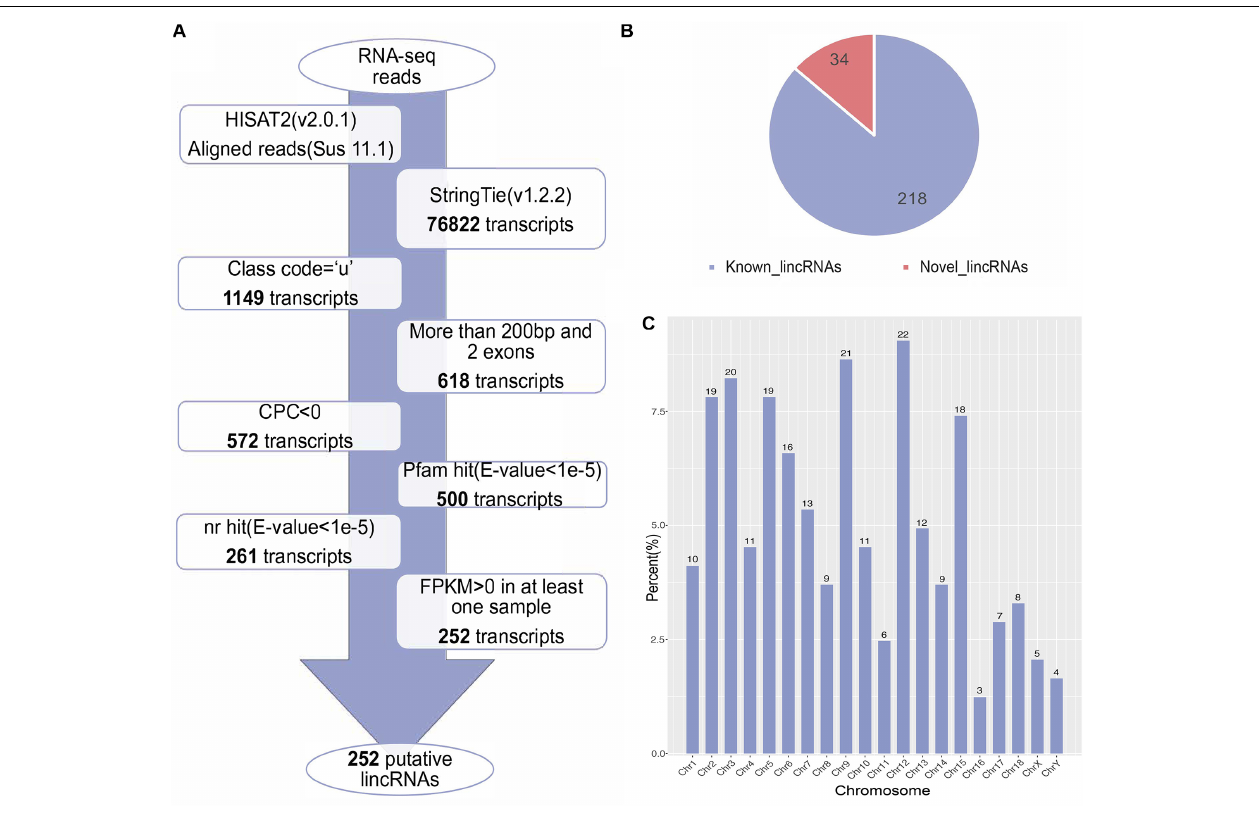
FIGURE 1 | (A) The pipeline for the identification of putative lincRNAs in this study. The frames in the direction of the arrow show the filtering process and the number of screened transcripts. (B) The number of known and novel lincRNAs. (C) The chromosome distribution of putative lincRNAs.